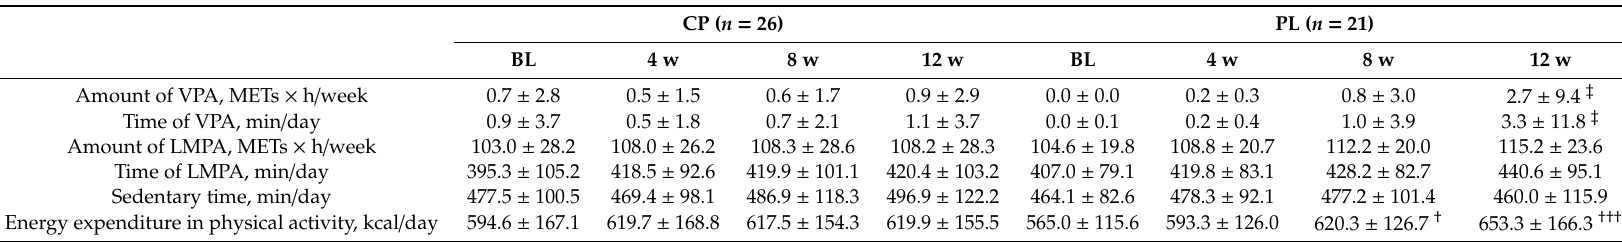
Table 3. Amount of vigorous and light-to-moderate physical activity and time spent in vigorous, light-to-moderate, and sedentary physical activity in all